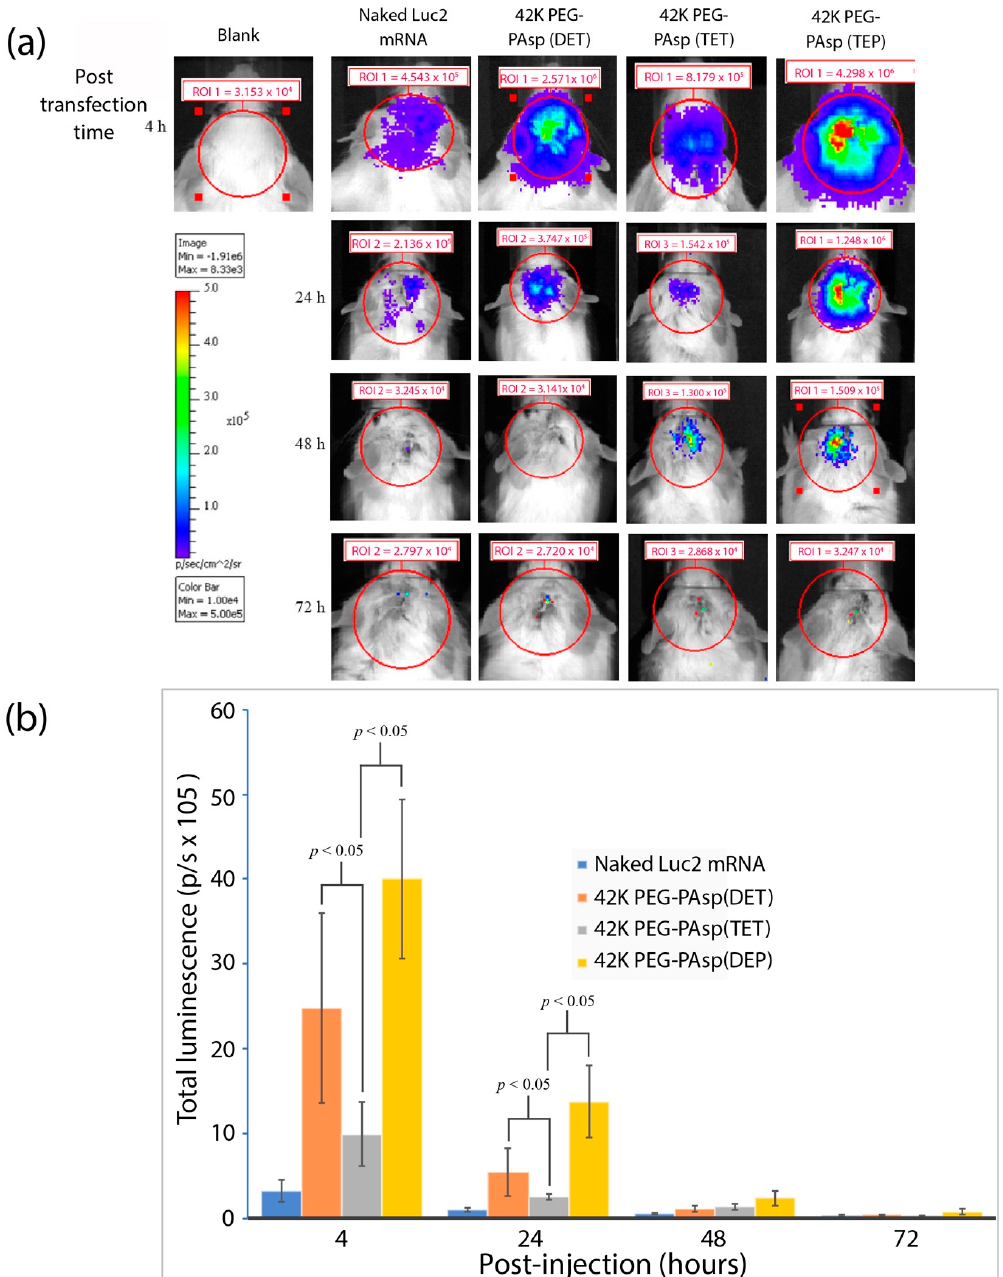
Figure 6. (a) IVIS analysis after Luc2 mRNA polyplex nanomicelles ICV-infusion over a course of 72 h to evaluate the efficacy of signal retention in the brain . ( b ) Total luminescence analysis at 4–72 h post-infusion.